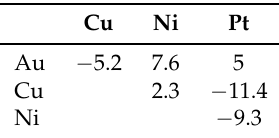
Table A2. Pair mixing enthalpies (in kJ/mol) of binary alloys with equimolar composition. The values were taken from [31].